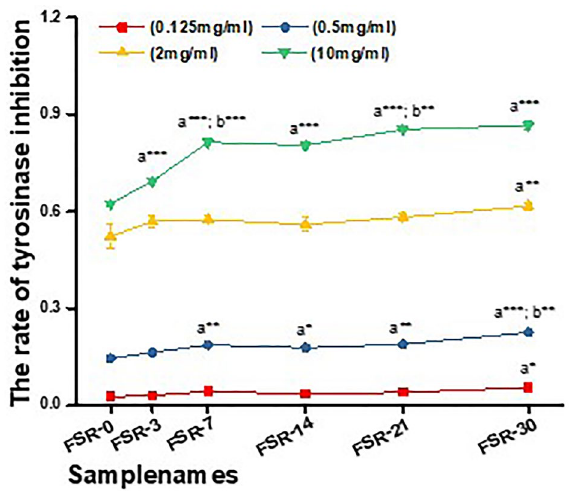
Figure 3. Effects of fermentation time and concentration of fermentation solution of Rosa ‘Dianhong’ (FSR) on tyrosinase inhibition. Each value represents mean ± SD ( n = 3). Different numbers of asterisks represent different levels of significance from one-way ANOVA: a, compared with FSR-0; b, compared with the previous sample; * P < 0.05; ** P < 0.01; *** P <